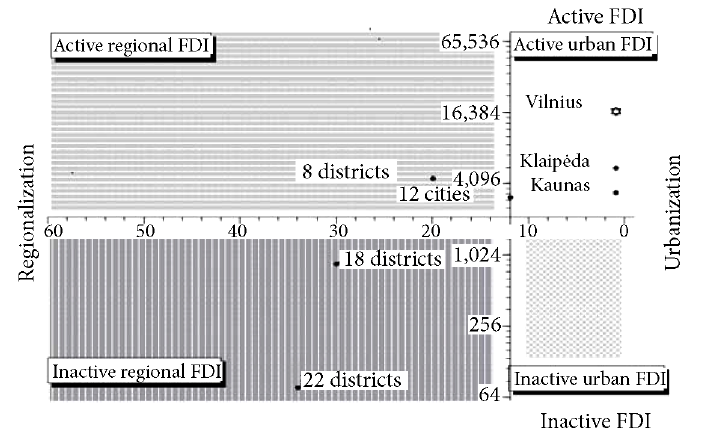
Figure 4. Regional policy formation scenarios representing the current situation of Lithuanian municipalities (made by authors) The bullet points of different FDI policy (Figure 4) were calculated using the data of FDI of all City Municipalities and District Municipalities and represent the current situations of Lithuania municipalities. The classification of District Municipalities is taken from Figure 2. In the right square at the top, which represents urbanization and active FDI ( Active urban FDI ), there are all 12 City Municipalities, but due to lack of place, only the three biggest cit- ies of Lithuania are marked. On the y-axis, the average of FDI of 12 cities takes place. In the left square at the top, which represents regionalization and active FDI ( Active regional FDI ), the point for eight Districts is shown. This bullet point, which is the average of FDI of the eight districts group (seven districts together with Mazeikiai District) is on point 20 on the x-axis. The explanation for this is the representation of the current situation. The 12 Cities block should be taken into consideration in all calculations of districts. The same principles of calculations were done with the 18 district and 22 district groups. Both groups take place in the left square below, which shows regionalization and inactive FDI ( Inactive regional FDI